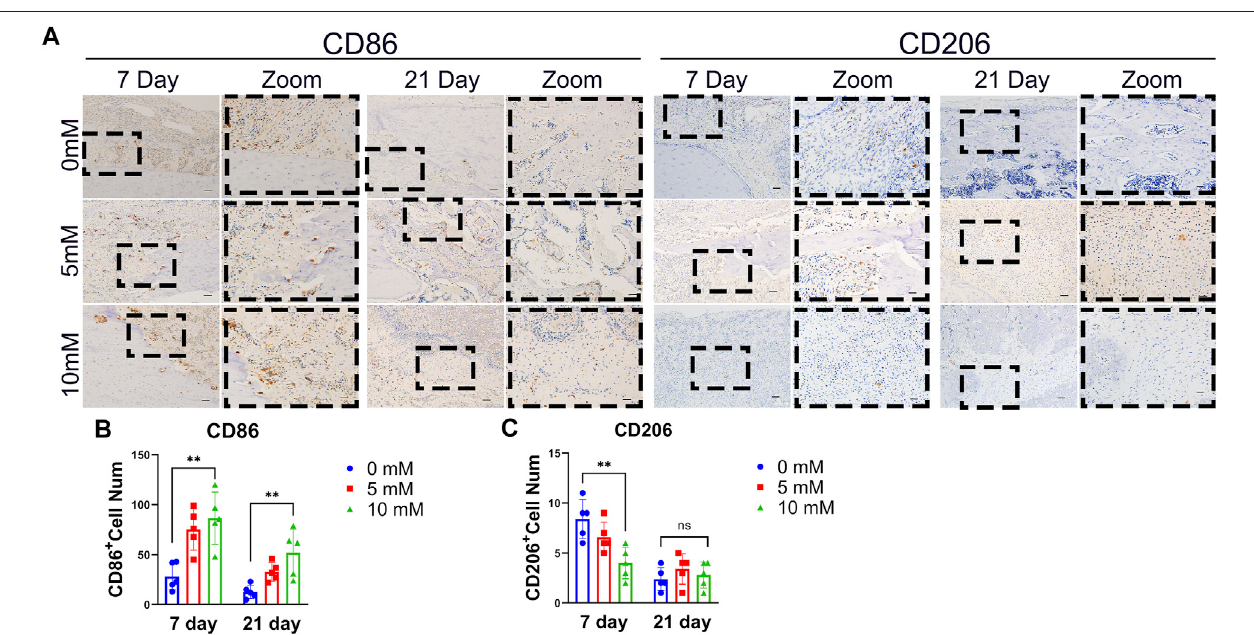
FIGURE 3 | Excessive fl uoride intake rats showed suppressed M2 macrophage differentiation at fracture sites. (A) M1 macrophage marker of CD86 and CD206 wasdetectedbyIHCat7and21 daysafter fracture.Thebar represents200 μ m(left)and50 μ m(right). (B) Relativepositivecellnumbersweredetected.Thedatainthe fi gures represent the averages ± SD. Signi fi cant differences are indicated as * p < 0.05 or ** p < 0.01, t -test, n =